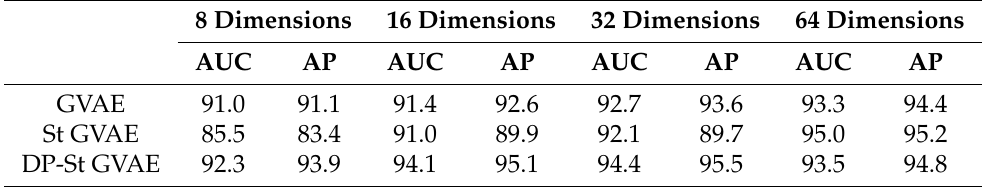
Table 2. Link prediction performance comparison of different dimensions for Cora.